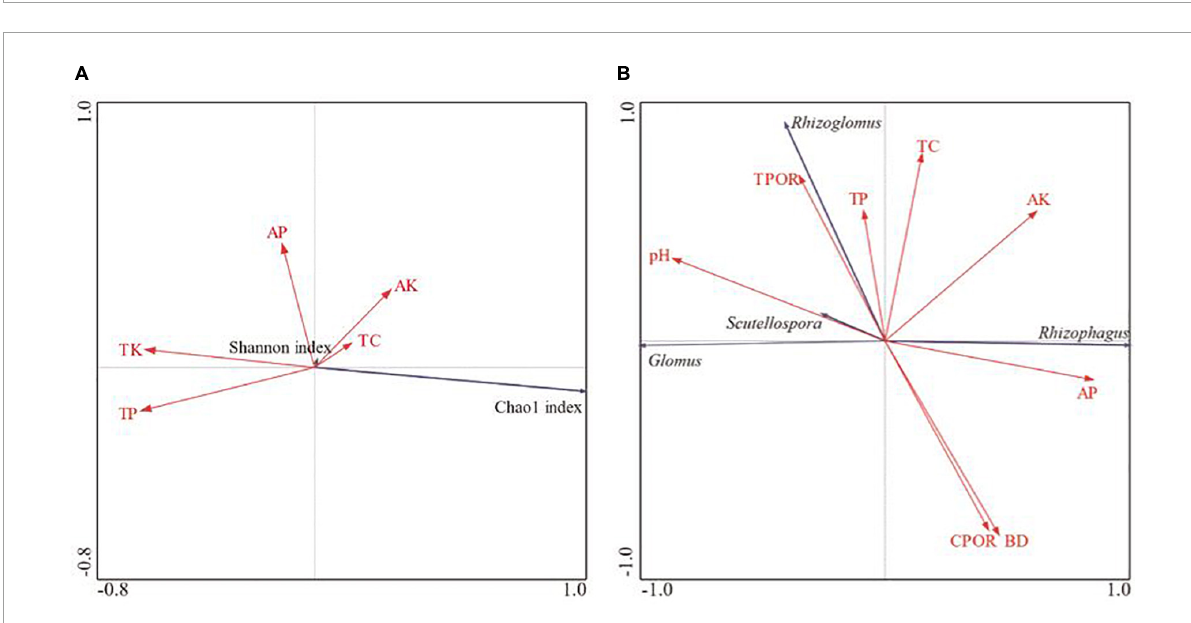
different selection pressures on different kinds of AMF and prioritize AMF that is more beneficial to themselves (Bever et al., 2009). Different plant genotypes will affect the coexistence of